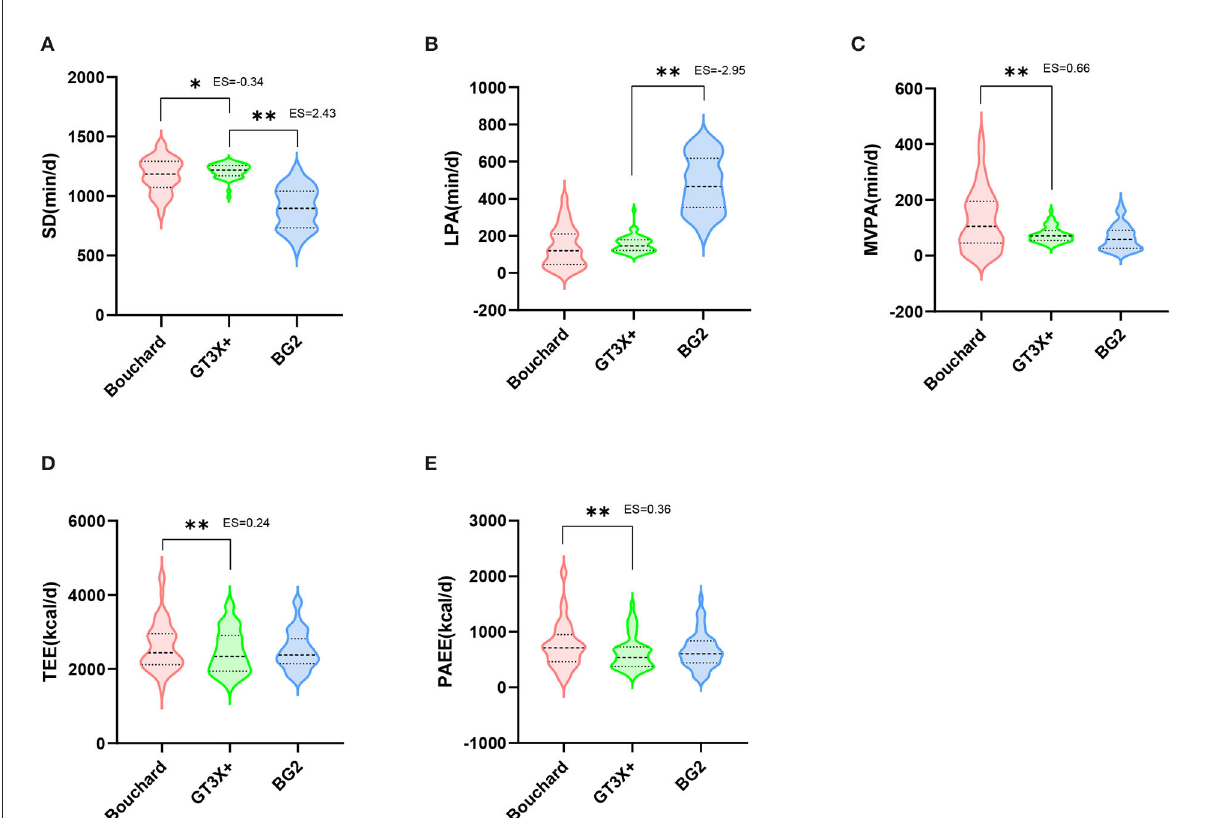
FIGURE2 The differences of SD, LPA, MVPA, TEE, and PAEE during the free-living by three methods. The thicker dashed line represents the median, and the thinner dashed line represents the inter quartile range. Two-tailed paired t -test P -values indicate statistical significance (* P < 0.05 and ** P <